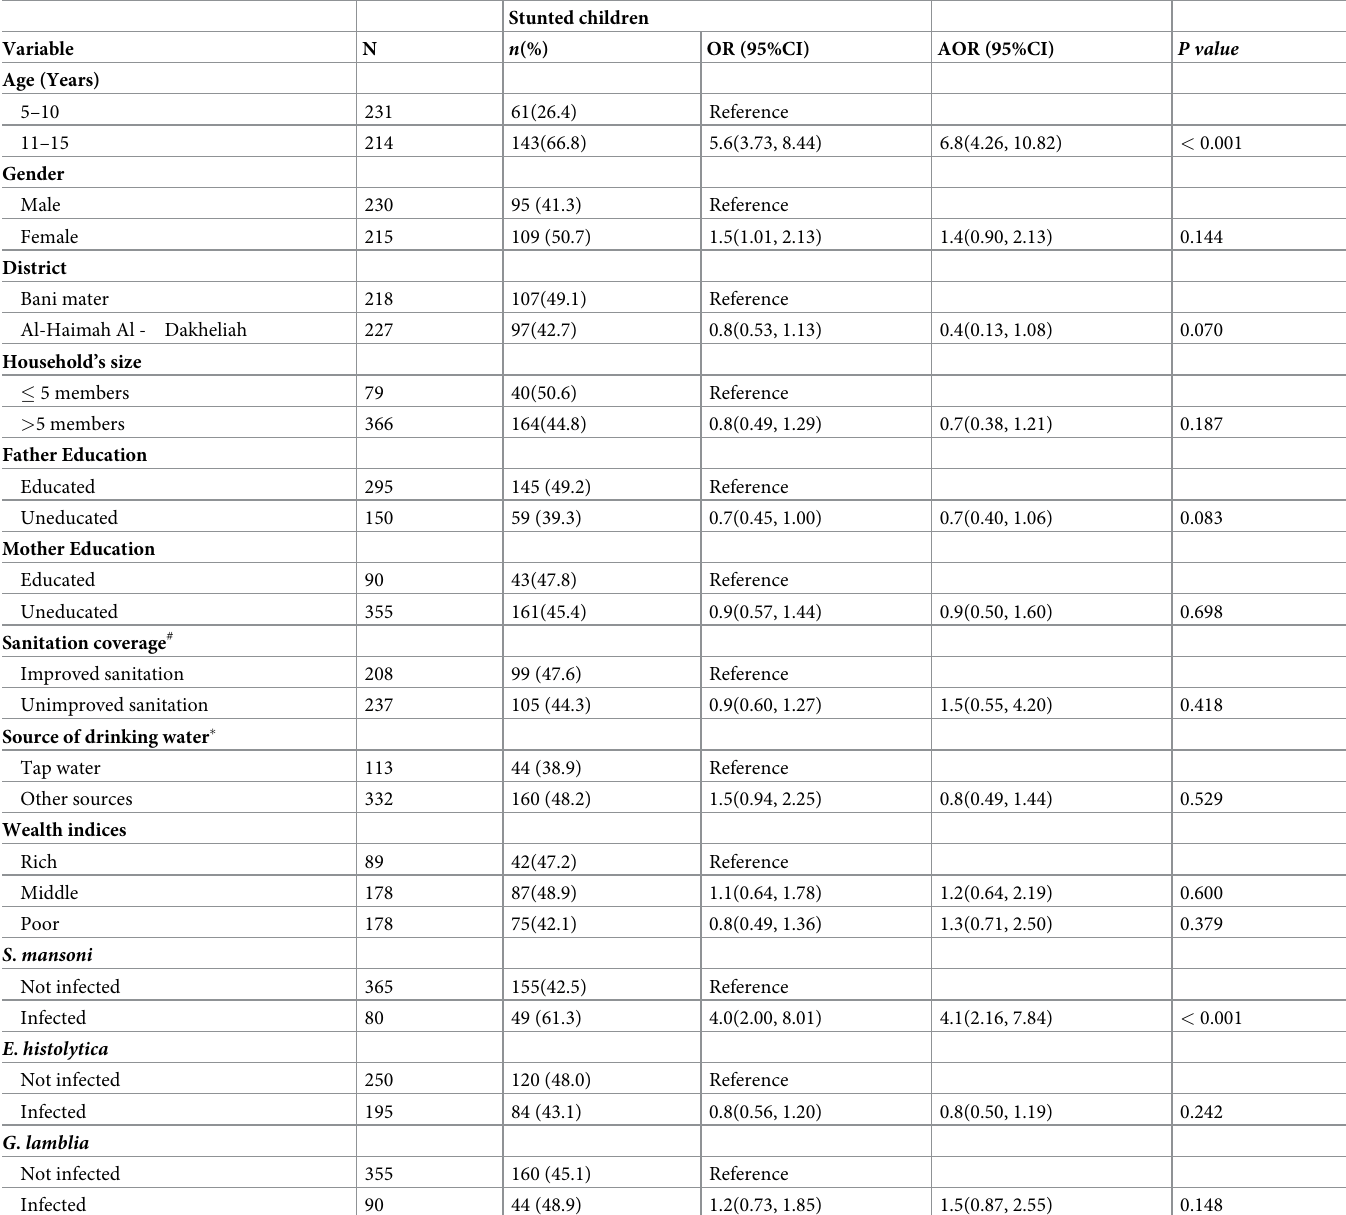
Table 6. Factors associated with stunting among schoolchildren, Sana’a Governorate, Yemen (N =